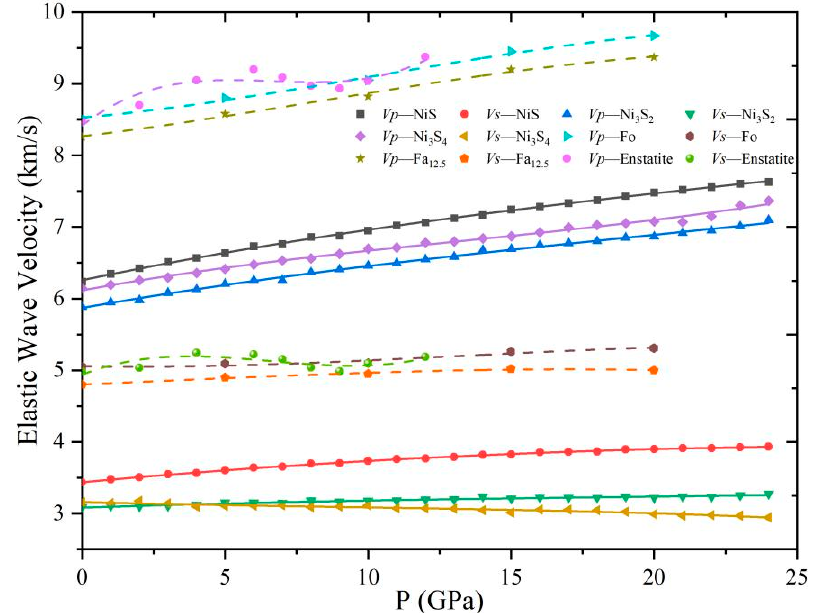
Figure 6. Comparison between the elastic wave velocity of Ni sulfides and that of olivine and enstatite.